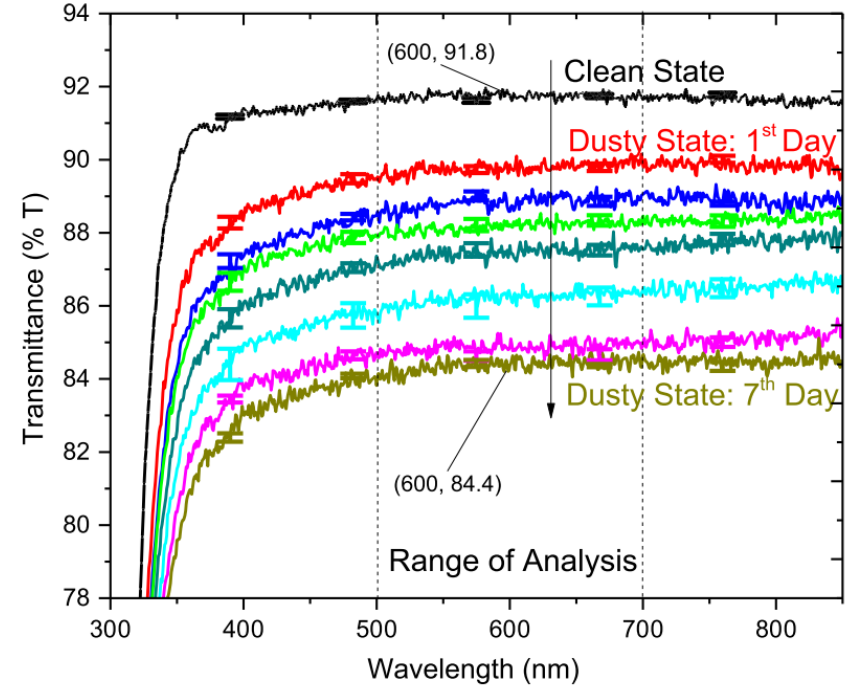
Figure 6. Soiling and its consequence on transmittance over one week of exposure. Reprinted from Solar Energy, 135, Al Shehri A et al., Impact of dust deposition and brush-based dry cleaning on glass transmittance for PV modules applications, 320., Copyright (2016), with permission from Elsevier [44].